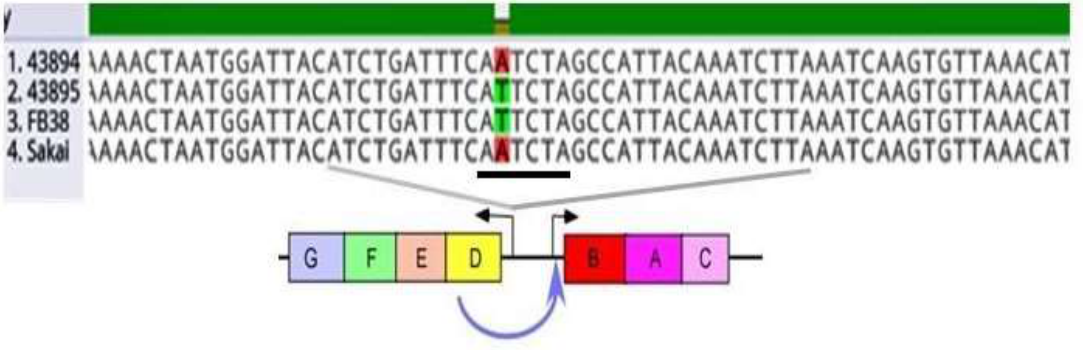
Figure 2. Biofilm/invasive-positive and -negative O157 strains differ by a single nucleotide in the promoter of csgD . A schematic of the divergent curli operons and partial DNA sequences of the intergenic regulatory region of four O157 strains are shown. Biofilm/invasive-positive strains, 43895 and FB38, and -negative strains, 43894 and Sakai, differ by a single nucleotide A to T transversion (highlighted in green or red) in the csgD promoter. Below the sequences, a schematic depicting how regulation of curli subunits B and A are dependent on csgD expression (blue arrow).